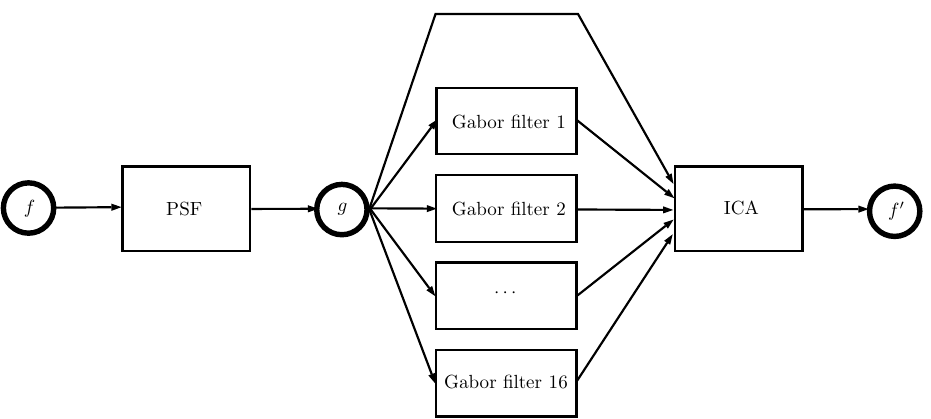
Figure 1. Schematic of the blurring process, the filtering process by 16 Gabor filters and of an ICA- based processing to recover a sharp image from a blurred image according to the method developed in